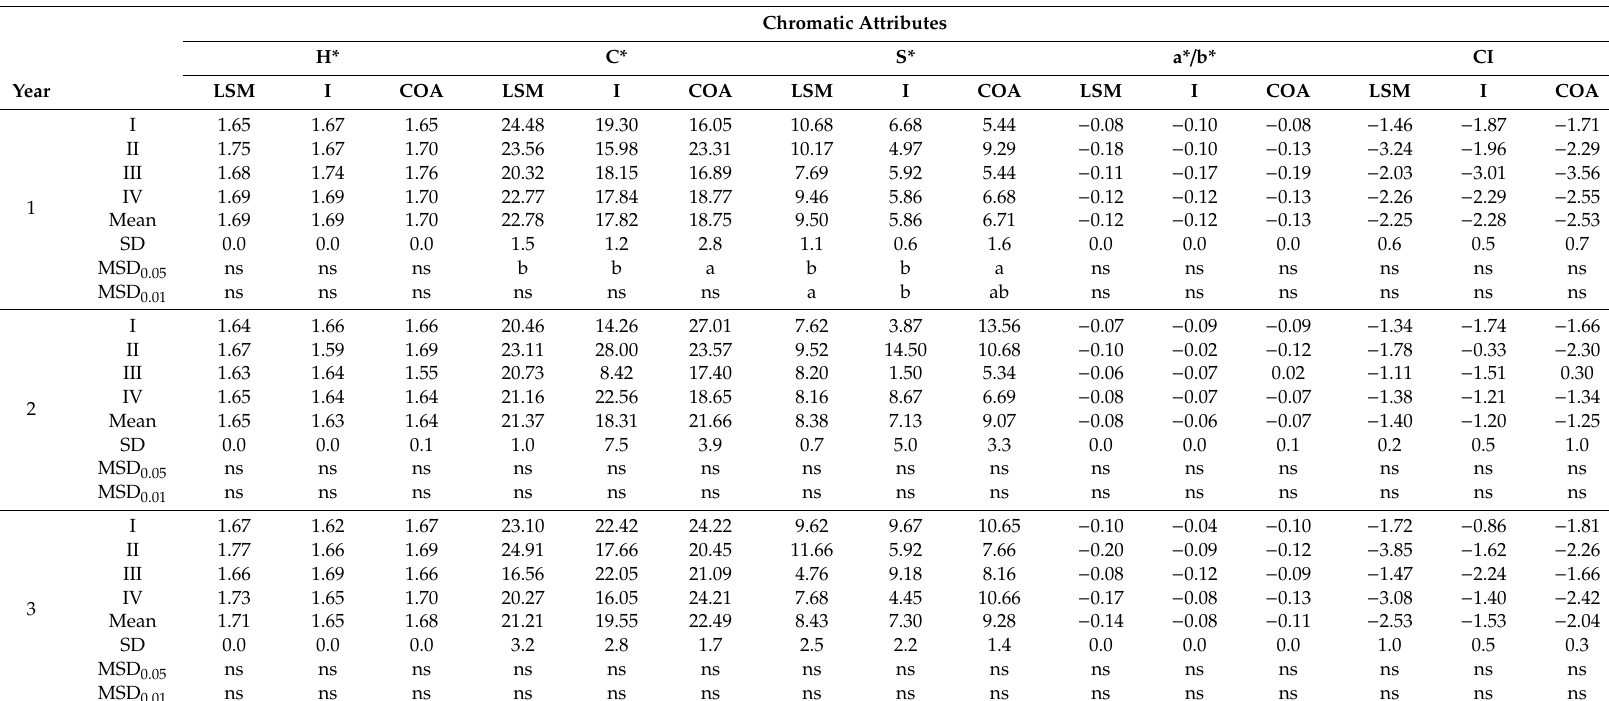
Table 6. Chromatic attributes (H*, C*, S*), a* / b* ratio, and color index (CI) during three cycles of celery crops grown in the field, as a function of the fertilization treatment: local sheep manure (LSM), inorganic treatment (I), and commercial organic amendment